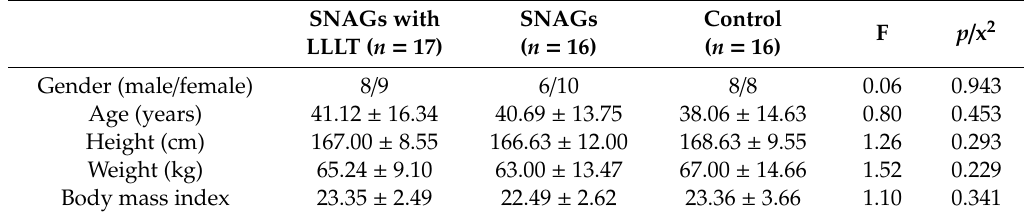
Table 1. General characteristics of the subjects ( N = 49).